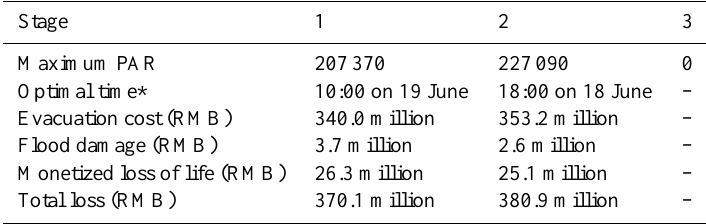
Table 9. The optimal decision and flood consequences in Mianyang